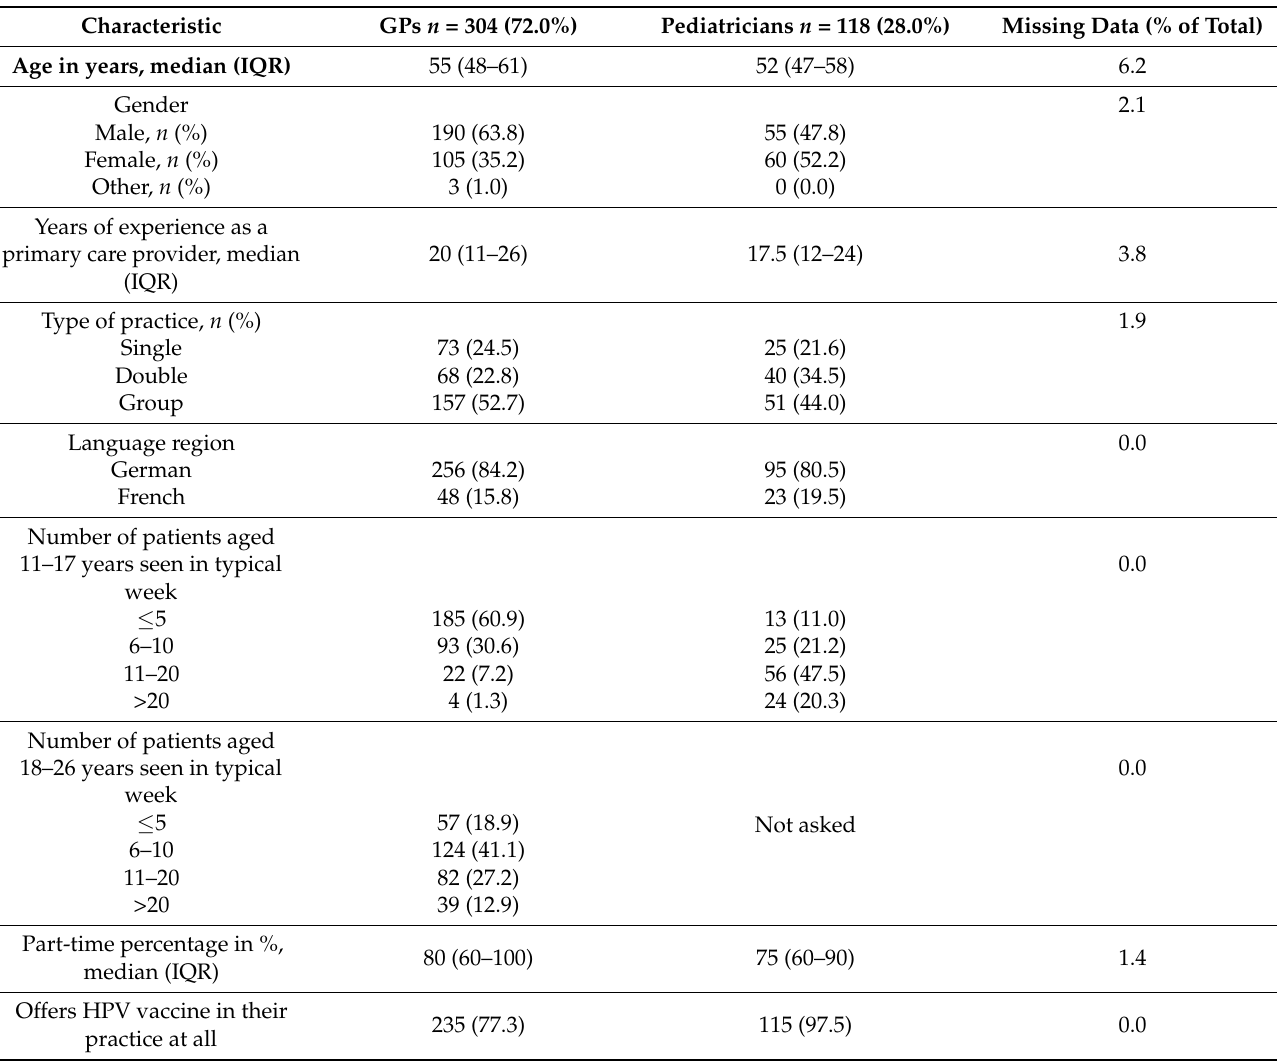
Table 1. Demographic and professional characteristics of included survey respondents ( n = 422). Abbreviations: general